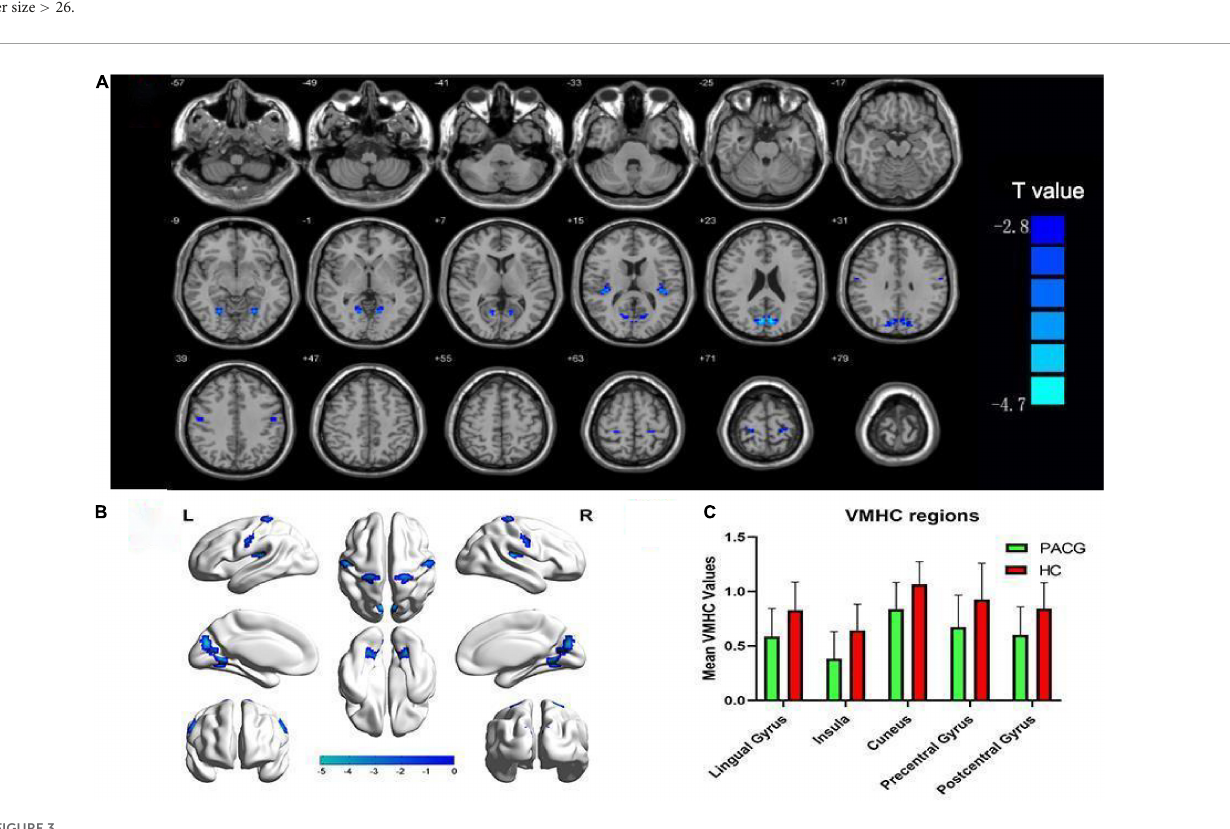
FIGURE3 Altered voxel mirrored homotopic connectivity (VMHC) in patients with primary angle-closure glaucoma (PACG) versus healthy controls (HC). (A,B) Significant VMHC values were observed in the lingual gyrus, insula, cuneus, and pre- and post-central gyri; ( P < 0.005; cluster > 26 voxels, AlphaSim corrected). (C) Mean values of altered VMHC values between the two groups. VMHC, voxel mirrored homotopic connectivity; HC, healthy control; PACG, primary angle-closure